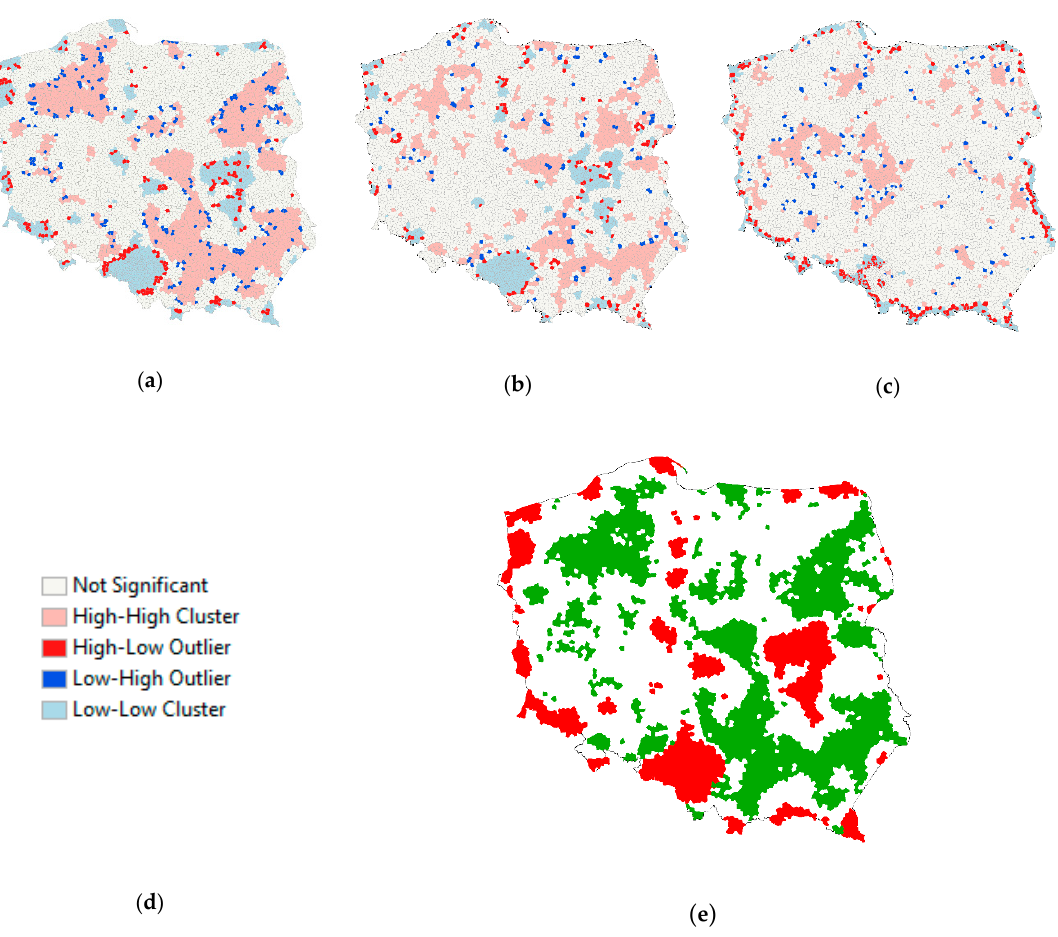
Figure 10. Anselin Local Moran statistics: ( a ) Thiessen polygons area; ( b ) nearest distance between BGCPs; ( c ) Thiessen polygons’ shape index (SI); ( d ) map legend; ( e ) clusters of dense (red) and thinned (green) Base Geodetic Network.